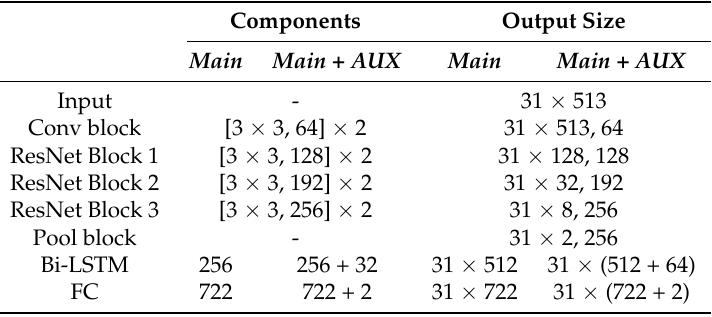
Table 1. Model configurations of the main and joint networks. ConvBlock and ResBlock have two convolutional layers; [ n × n , k ] denotes a convolutional operator of n filters and a kernel size of k